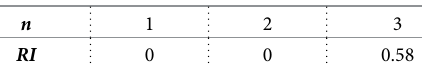
Table 9. RI values [27].